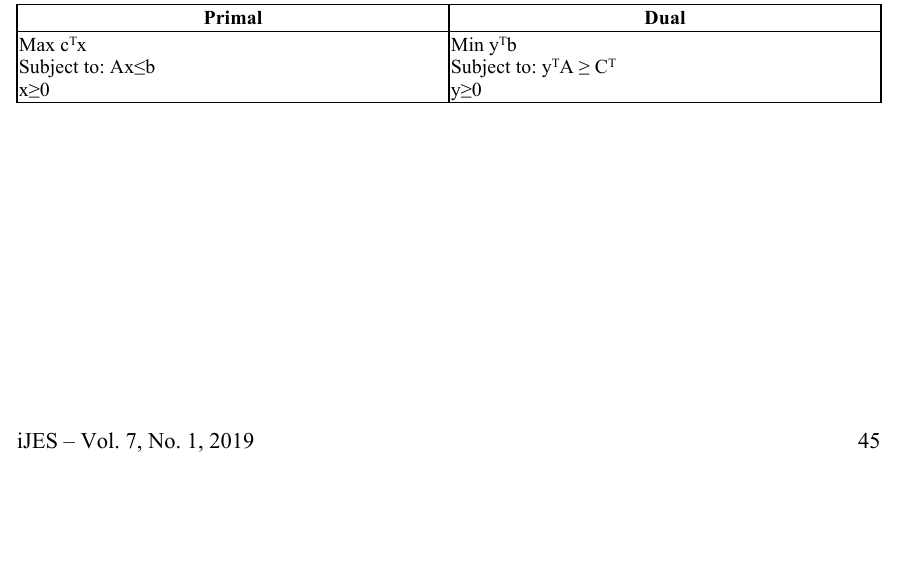
Table 1. Primal and